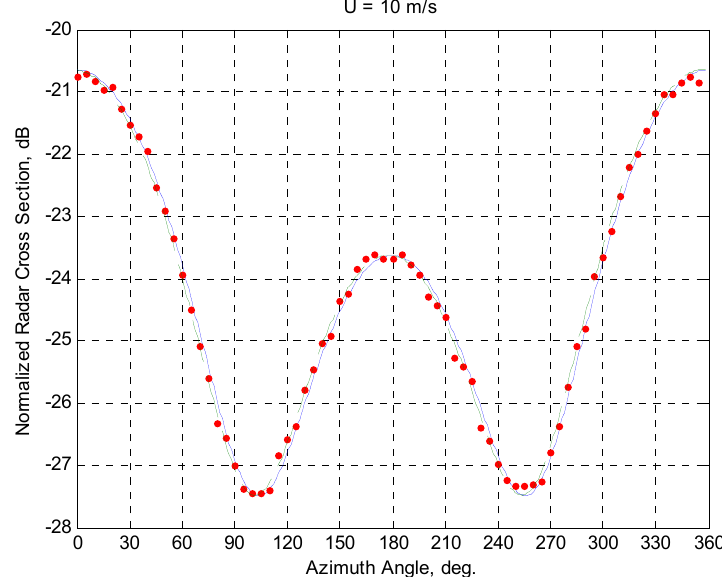
Figure 3. Azimuth NRCS curve using Equation (1) at the incidence angle of 45 ˝ , “true” wind speed of 10 m/s and “true” up-wind direction of 0 ˝ (solid line); generated “measured” NRCS after the averaging of 1565 samples in a five-degree azimuth sector (red dots); and azimuth NRCS curve using Equation (1) corresponding to “measured” wind speed of 10.0071 m/s and up-wind direction of 357.9 ˝ retrieved from the azimuth sector of [45 ˝ , 225 ˝ ] (dashed